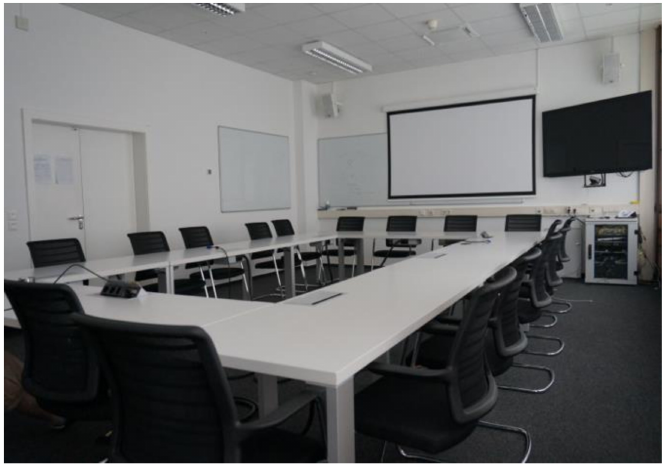
Figure 4. Meeting room (Supplementary